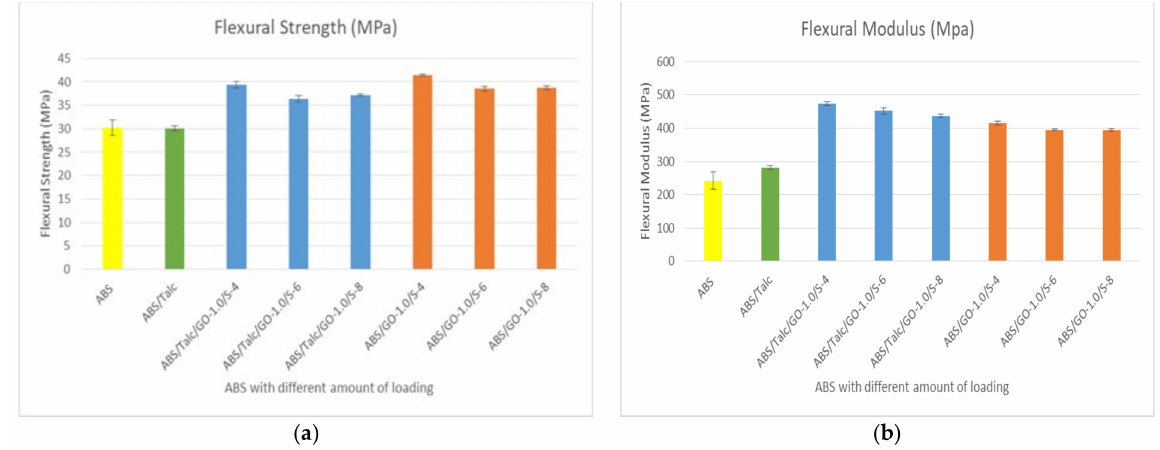
Figure 7. ( a ) Flexural strength and ( b ) flexural modulus of ABS and ABS/talc, with different loading of SEBS-g-MAH.